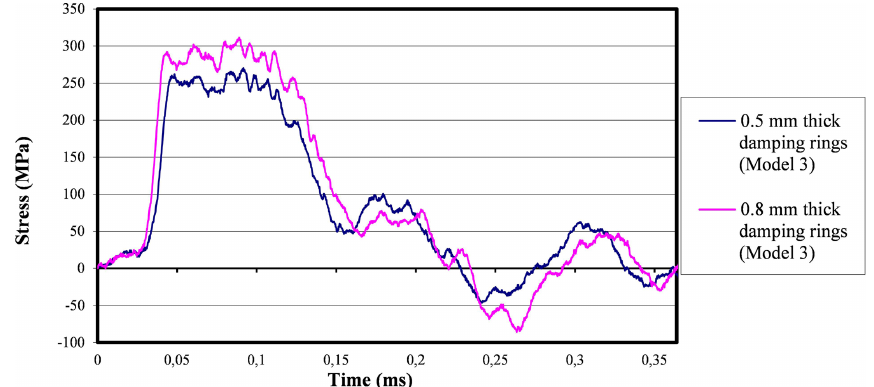
Figure 30. Incident and reflected stress-time curves pertinent to the actual experiment at 3.5bar when using 0.8 and 0.5mm thick damping rings.